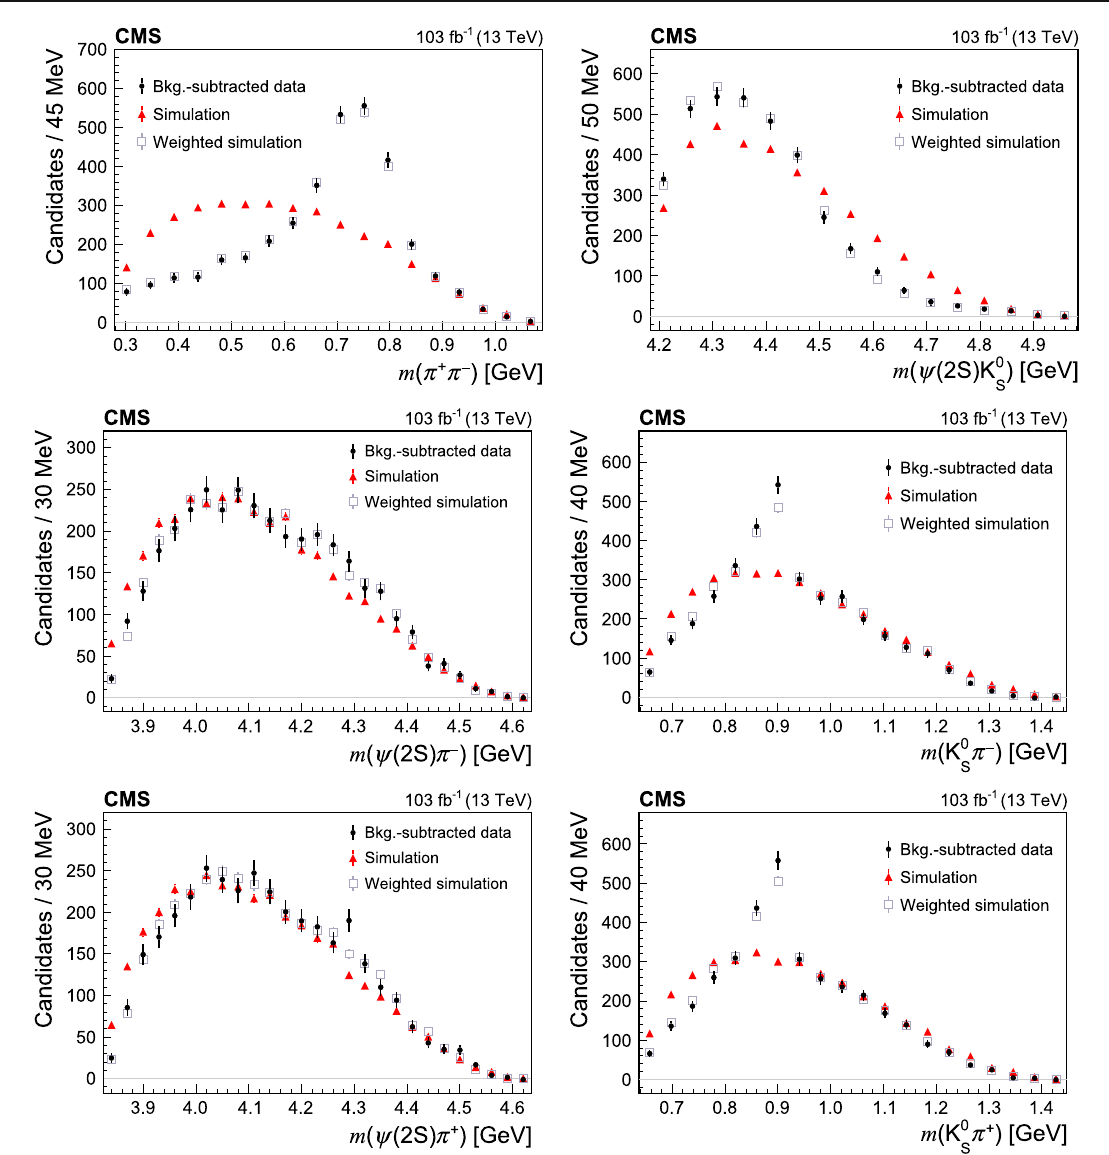
simulations (red triangles), as well as the predictions after applying the reweighting procedure described in Sect. 7 (grey